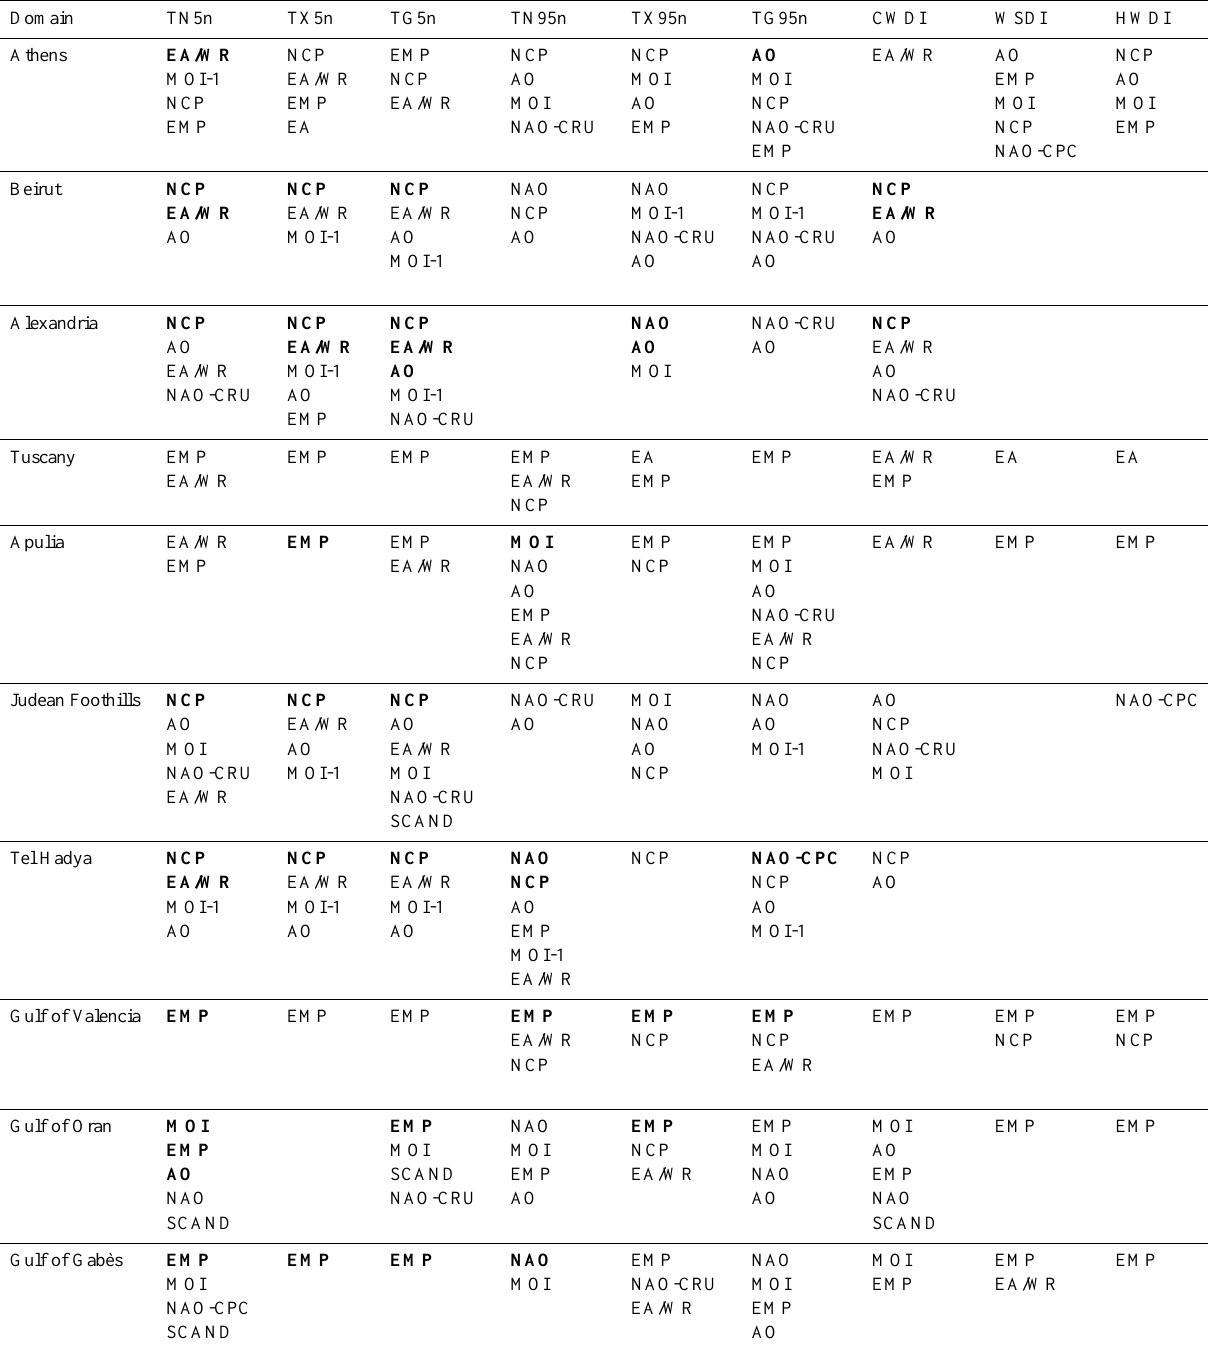
Table 7. Relationships between indices of temperature extremes calculated from E-OBS and atmospheric circulation indices in winter (DJF) for the period 1958–2008. Only circulation indices that explain ≥ 10% of an index of extremes time variance in both un-filtered and filtered time series and that have Spearman correlations which are significant at the 95% level appear in the table. Indices that explain ≥ 40% of variance are shown in bold. Best-associated circulation indices are ordered first in each cell. NAO and MOI denote that both versions (NAO-CRU/NAO-CPC and MOI-1/MOI-2, respectively – see Table 3) are associated with the respective index of